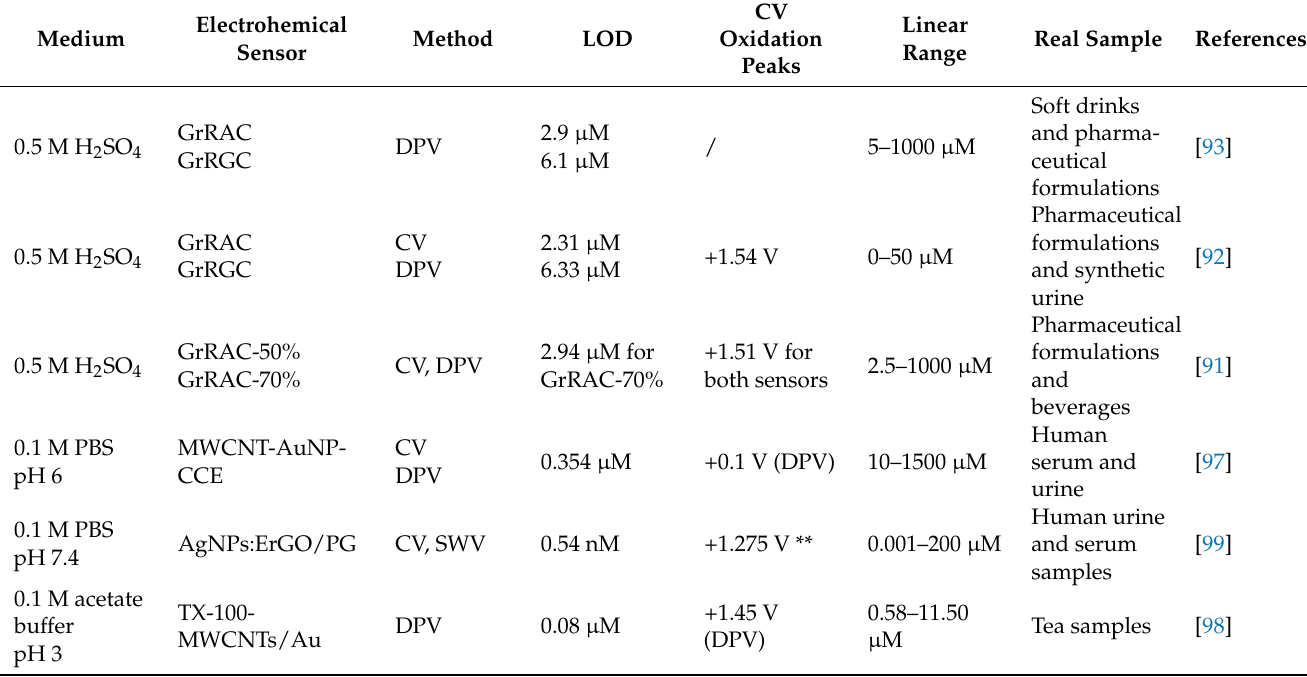
Table 6. Electrochemical characteristics of other carbon-based electrodes as sensors for caffeine